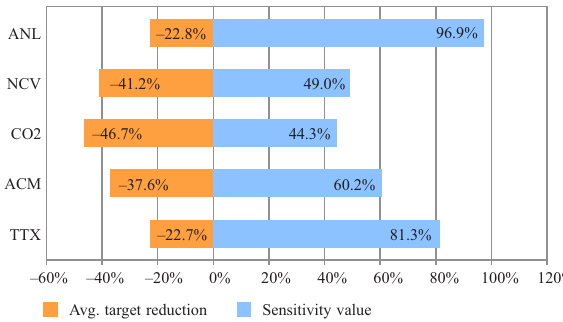
Fig. 3. Sensitivity analysis vs. average target reduction